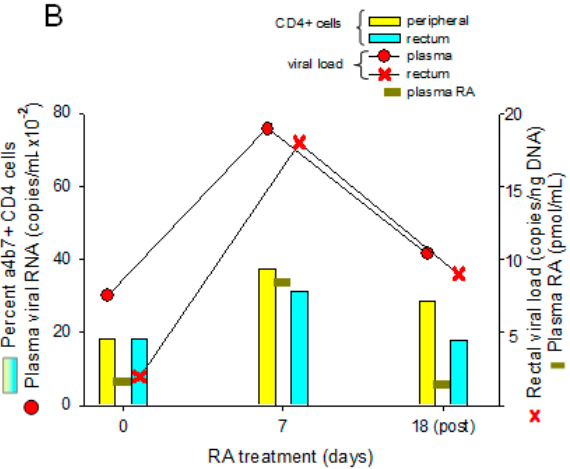
Figure 6. In vivo administration of RA to macaques with low viral loads. Monkeys were fed 10 mg/kg/day all-trans RA (orally) for 10 days, then followed for another 32 days. ( A ) Increased α 4 β 7 expression on CD4+ lymphocytes. Central memory, effector memory, and naïve CD4+ lymphocytes were gated based on their dual expression of CD28 and CD95 [4] and quantified for percent α 4 β 7 + cells. Naïve CD4 + T cells were categorized as CD28 + /CD95 − , central memory CD4 + T cells as CD28 + /CD95 + , and effector memory CD4 + T cells as CD28 − /CD95 + . Results represent the mean ± SEM of 4 monkeys. * p < 0.05, significant difference compared with baseline (day 0) values. ( B ) Representative example of a “spontaneous controller” monkey from “A” showing the correlation of plasma and rectal viral load with RA levels and expression of α 4 β 7 . Adapted from Olwenyi OA, 2020 [93].